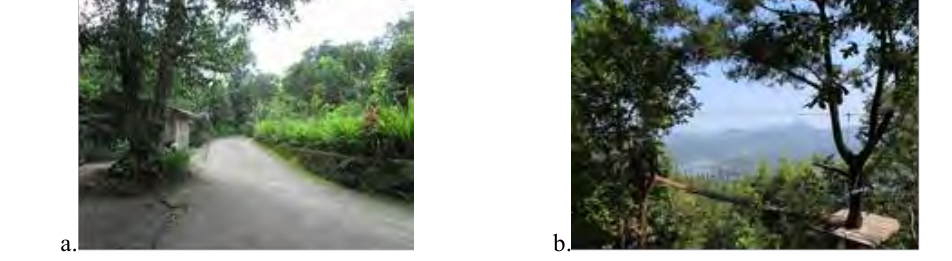
Figure 8(a) rural atmosphere in Pentingsari (author, 2017) Figure 9(b) landscape in Kalibiru (author, 2017)